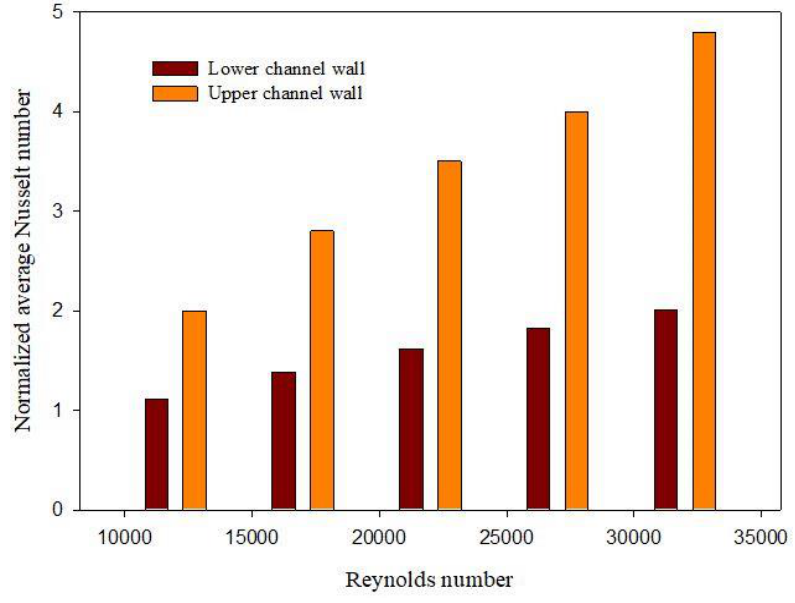
Figure 14. Dimensionless average Nusselt number vs. Re.